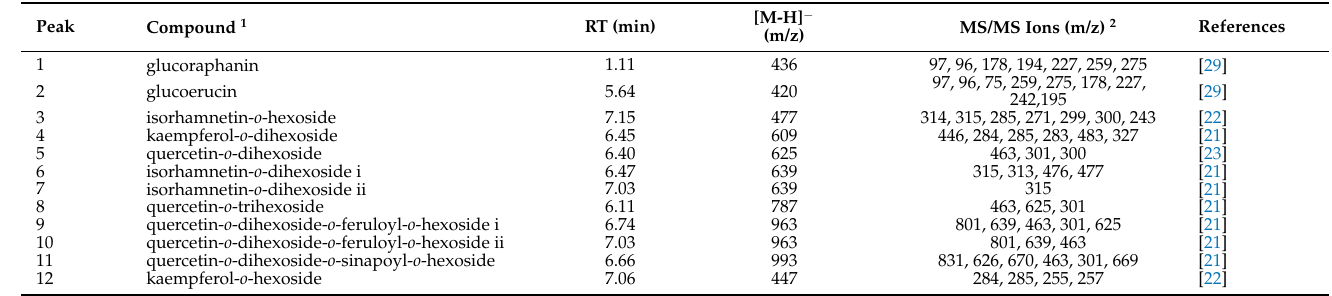
Table 2. Chromatographic characterization of compounds identified by UHPLC-MS/MS in the methanolic extracts of rocket salad sample washed in PAW for 20 min or untreated sample (UT).